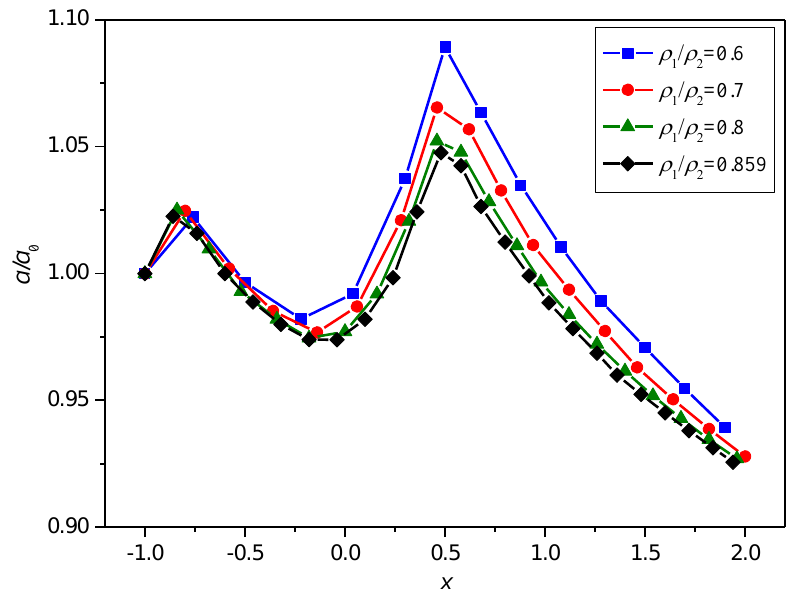
Figure 11. Variation in dimensionless wave amplitude for different densities jump of two-layer fluids with initial wave amplitude a 0 /h 1 = 0.4.